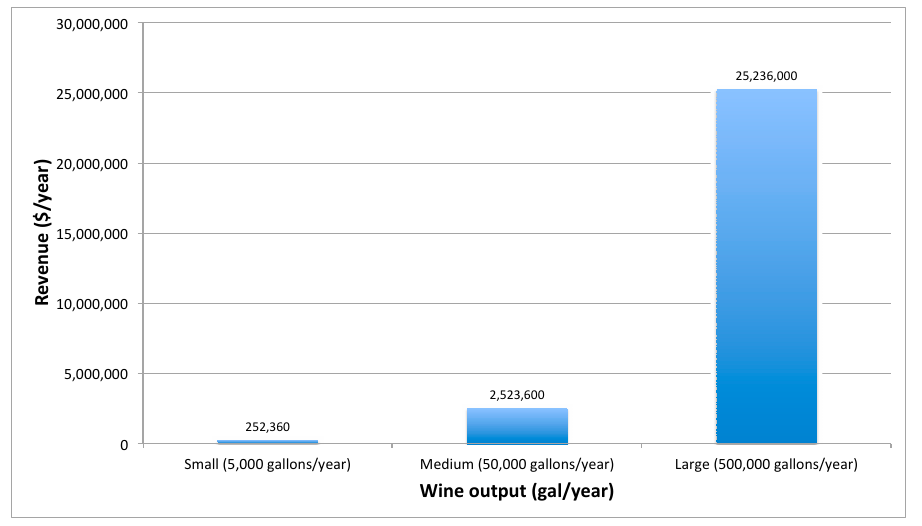
Figure 7. Annual revenues according to scale of operation.